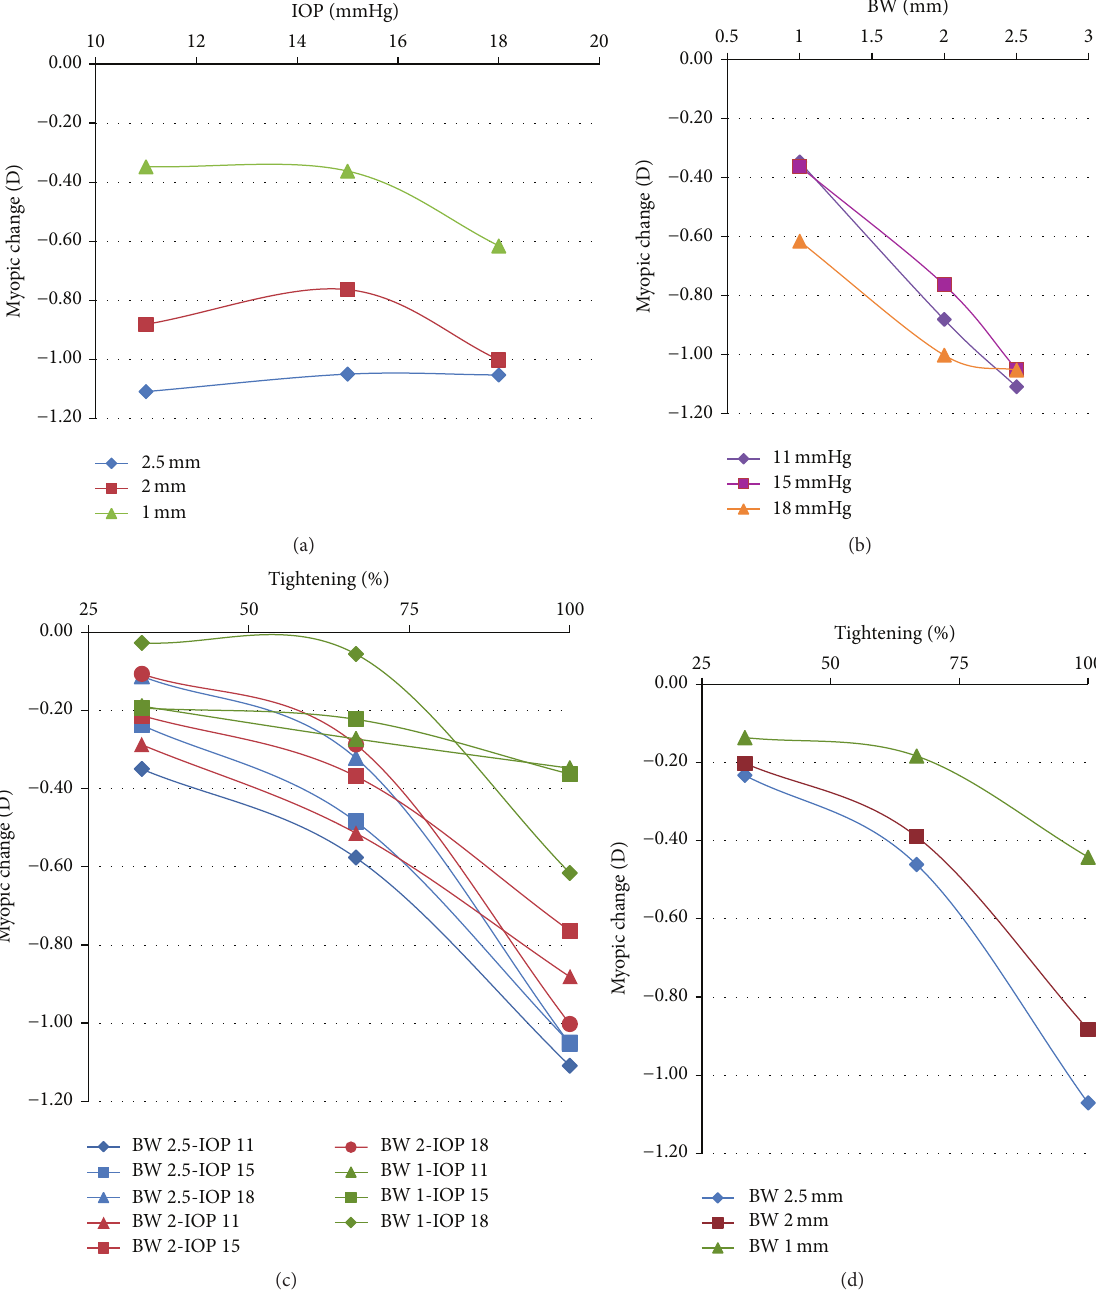
Figure 3: Influence of (a) IOP (mmHg) and (b) BW (mm) on the myopia induced, in diopters (D). No clear tendency of the induced myopia is observed with increasing IOP. On the contrary, bandwidth has a role in the postsurgical myopia change. The wider the band is, the greater the degree of myopia is induced. (c) Myopic changes obtained for all the simulated cases. (d) Mean values of the myopic change induced by the three bandwidths considered: 1, 2, and 2.5